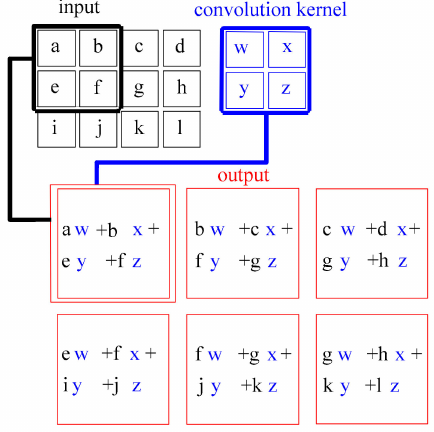
Figure 1. Schematic of the 2-D convolution